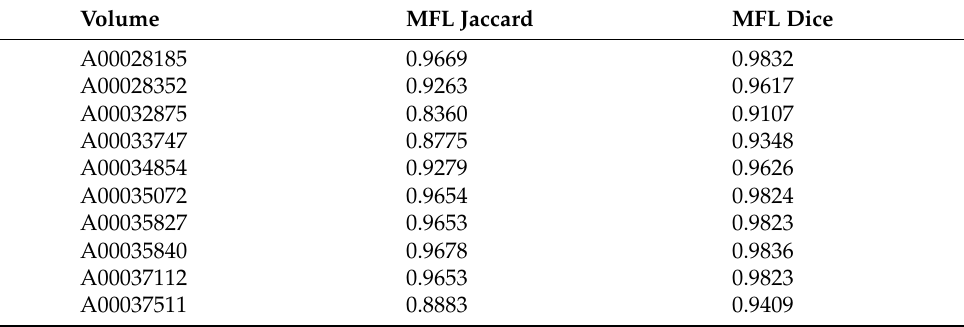
Table 3. Jaccard and Dice indices computed for 10 volumes obtained from the neurofeedback skull- stripped (NFBS)